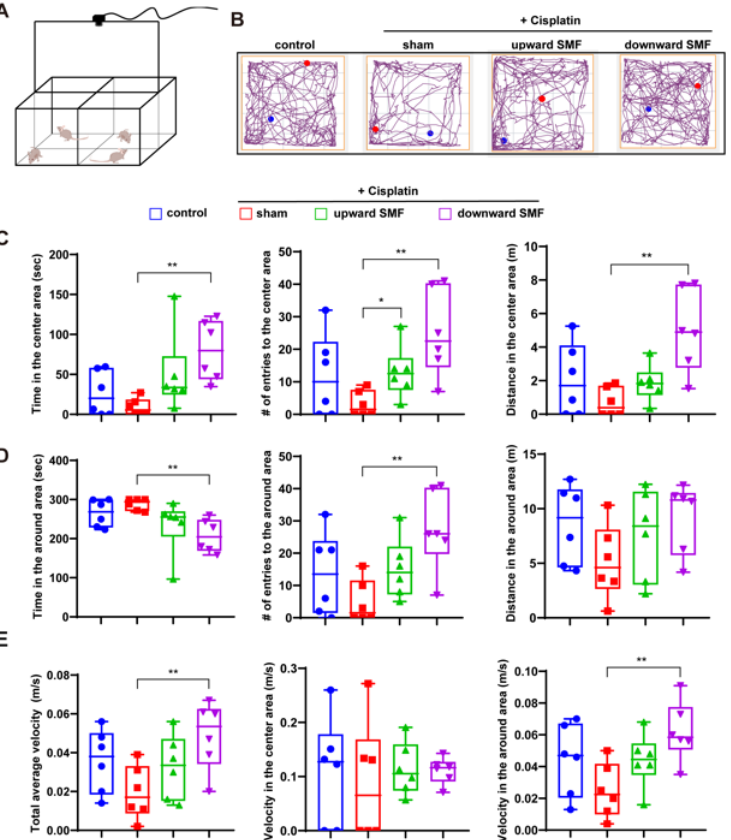
Figure 3. SMFs enhanced the locomotive and exploratory activities of cisplatin-treated tumor-bearing mice. ( A ) Illustration of the OFT experiment setup. ( B ) Representative trajectories of mice in the OFT. The blue and red dots show start and end points, respectively. ( C ) The movement parameters of mice in the center area, including time, number of entries and distance. ( D ) The movement parameters of mice in the surrounding area, including time, number of entries and distance in the surrounding area. ( E ) Velocity of mice during the whole test, in the center or surroundings. There were six mice in each group. Data are represented as means ± SD. Statistical significance is labeled as * p < 0.05, ** p <